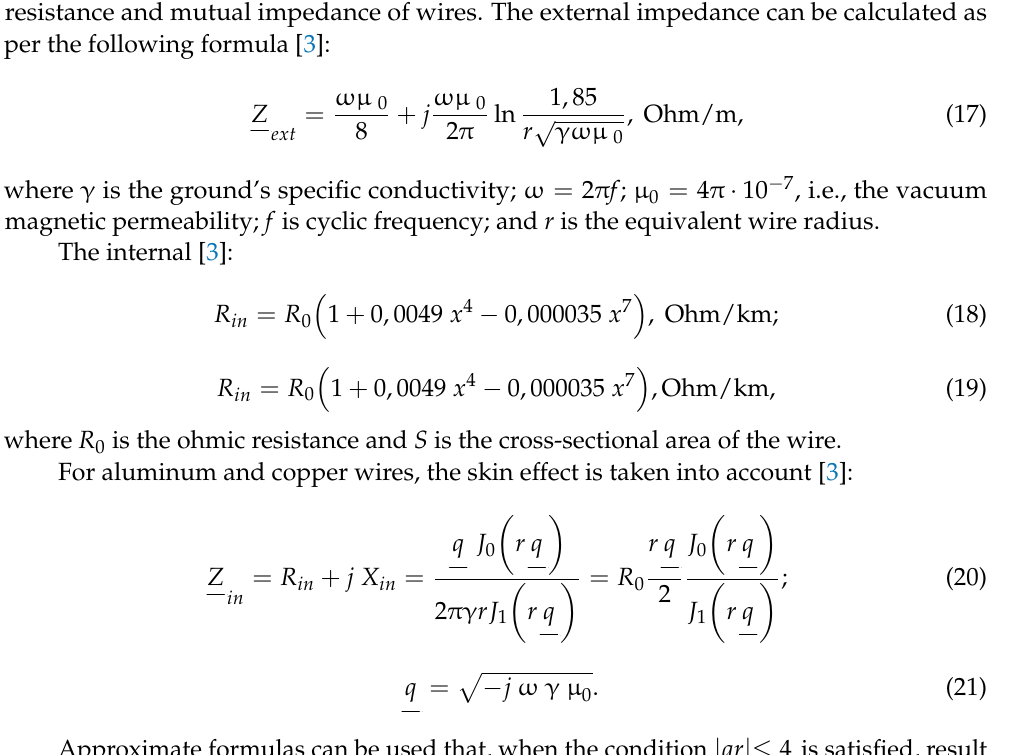
Figure 5. Original circuit of the power transmission line.